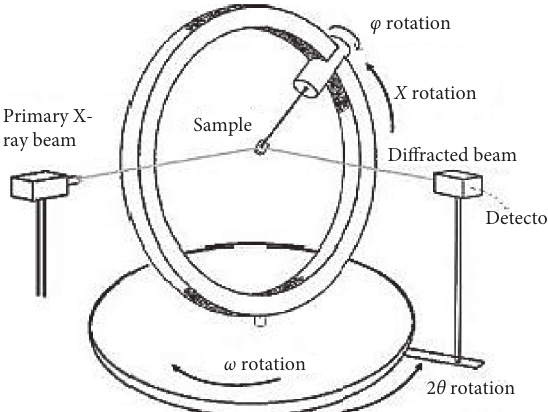
Figure 8: Goniometer head with a detector.